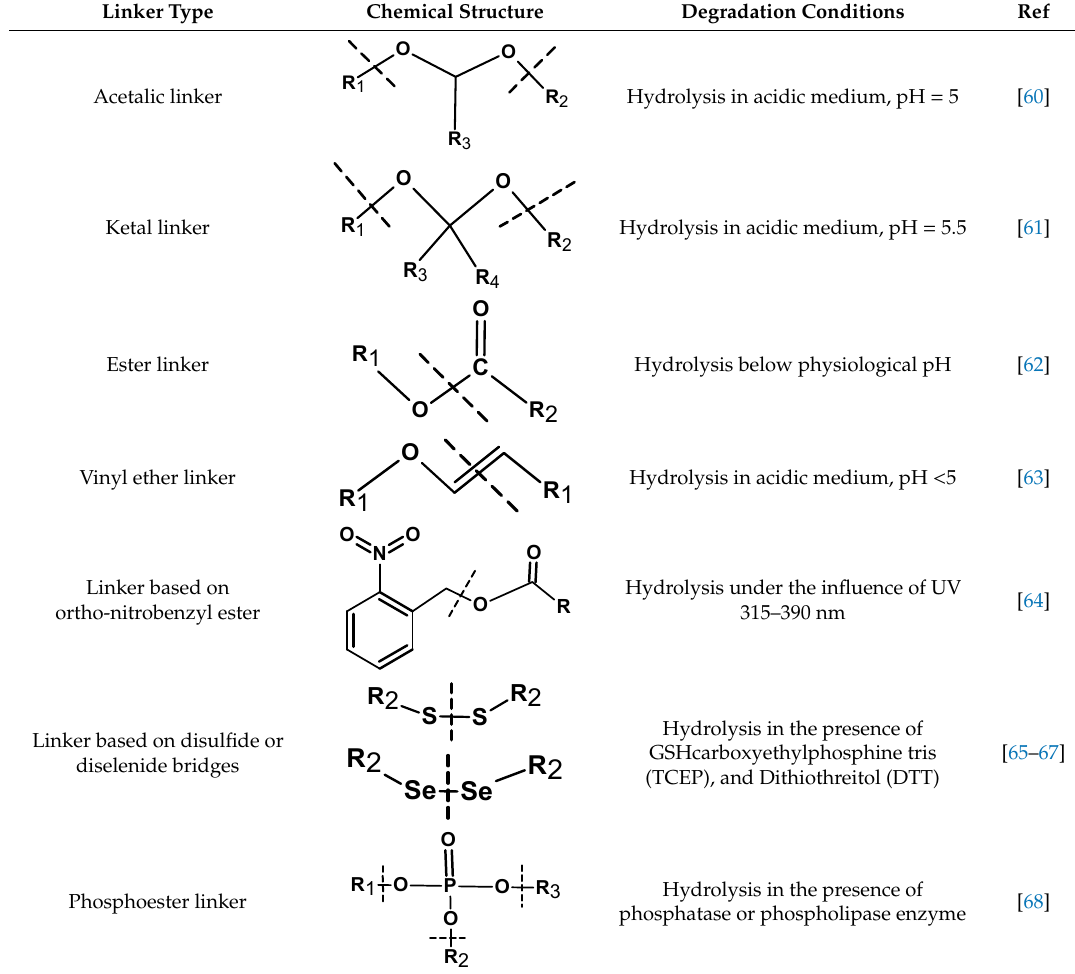
Table 2. Labile bonds introduced for e ff ective release from hybrid NGs. Table 2. Labile bonds introduced for effective release from hybrid NGs. Table 2. Labile bonds introduced for effective release from hybrid Table 2. Labile bonds introduced for effective release from hybrid NGs. Table 2. Labile bonds introduced for effective release from hybrid NGs. Table 2. Labile bonds introduced for effective release from hybrid NGs. Table 2. Labile bonds introduced for effective release from hybrid NGs.